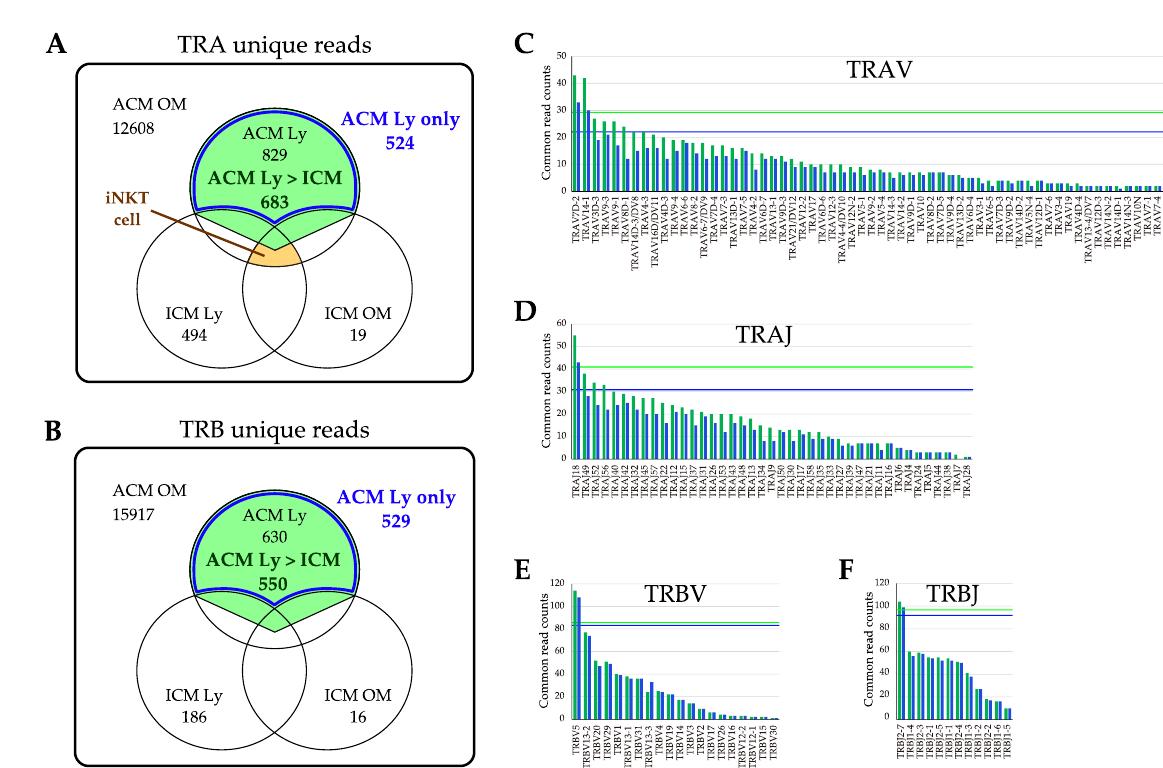
Figure 7. Common read counts of ACM OM and ACM Ly repertoire. ( A , B ) The number of unique reads common to the ACM OM mice and other samples is shown in the Venn diagram ( n = 3, total). The green shading is unique reads present in ACM OM to those that were increased in ACM Ly mice over ICM. Blue box lines are unique reads present in ACM OM to those that were present only in ACM Ly mice. ( C – F ) The common unique reads between ACM OM and Ly mice were counted for TRAV, TRAJ, TRBV, and TRBJ genes, respectively. The green bars are unique reads present in ACM OM to those that were increased in ACM Ly mice over ICM. The blue bars are unique reads present in ACM OM to those that were present only in ACM Ly mice. The green line is the mean + 2SD of green bars. The blue line is the mean + 2SD of blue bars.